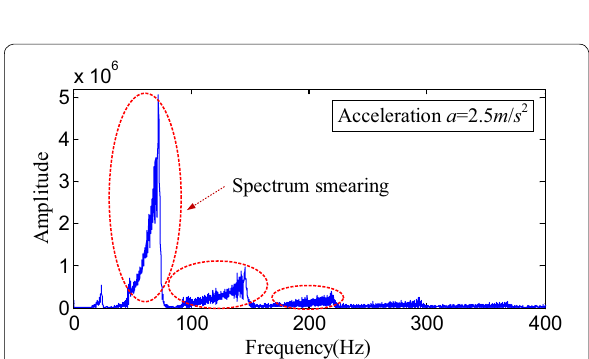
Figure 2 Envelope spectrum of faulty bearing signal